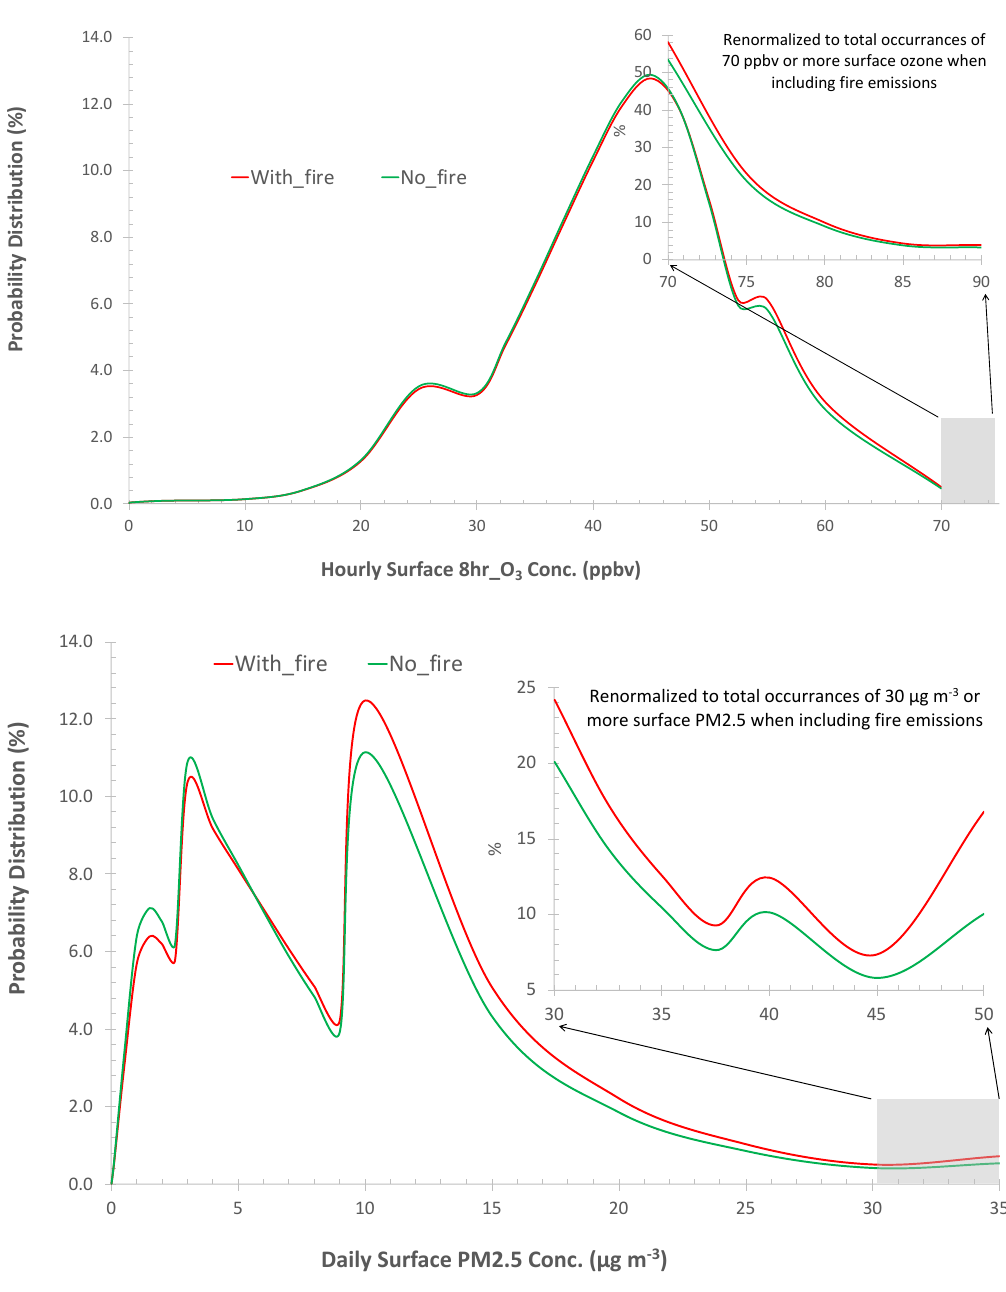
Figure 7. Probability distribution of surface 8-hr average O 3 ( top ) and 24-hr average PM 2.5 ( bottom ) concentrations over the contiguous U.S. The inlet on each plot is the re-normalized probability distribution of the corresponding pollutant at tail with high